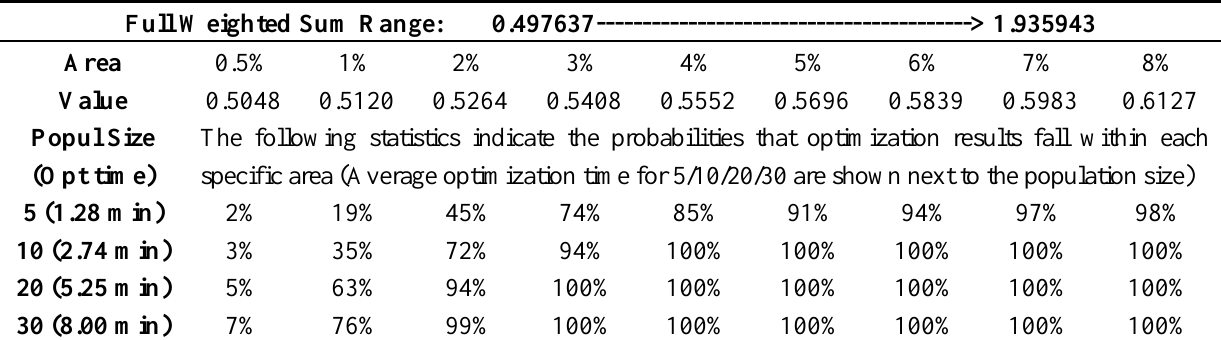
Table 4. Test results of GA-based